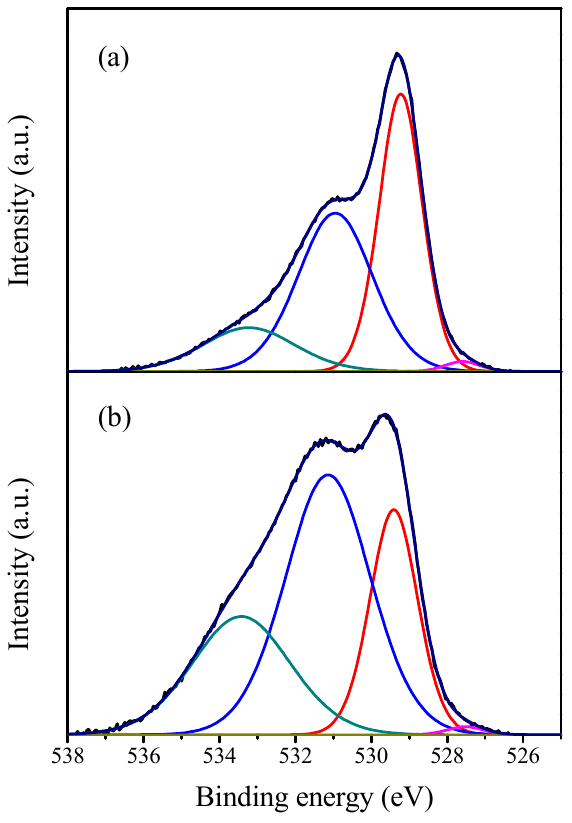
Figure 8. O 1s XPS spectra of bare NiO ( a ) and Gd/NiO ( b ) catalysts.